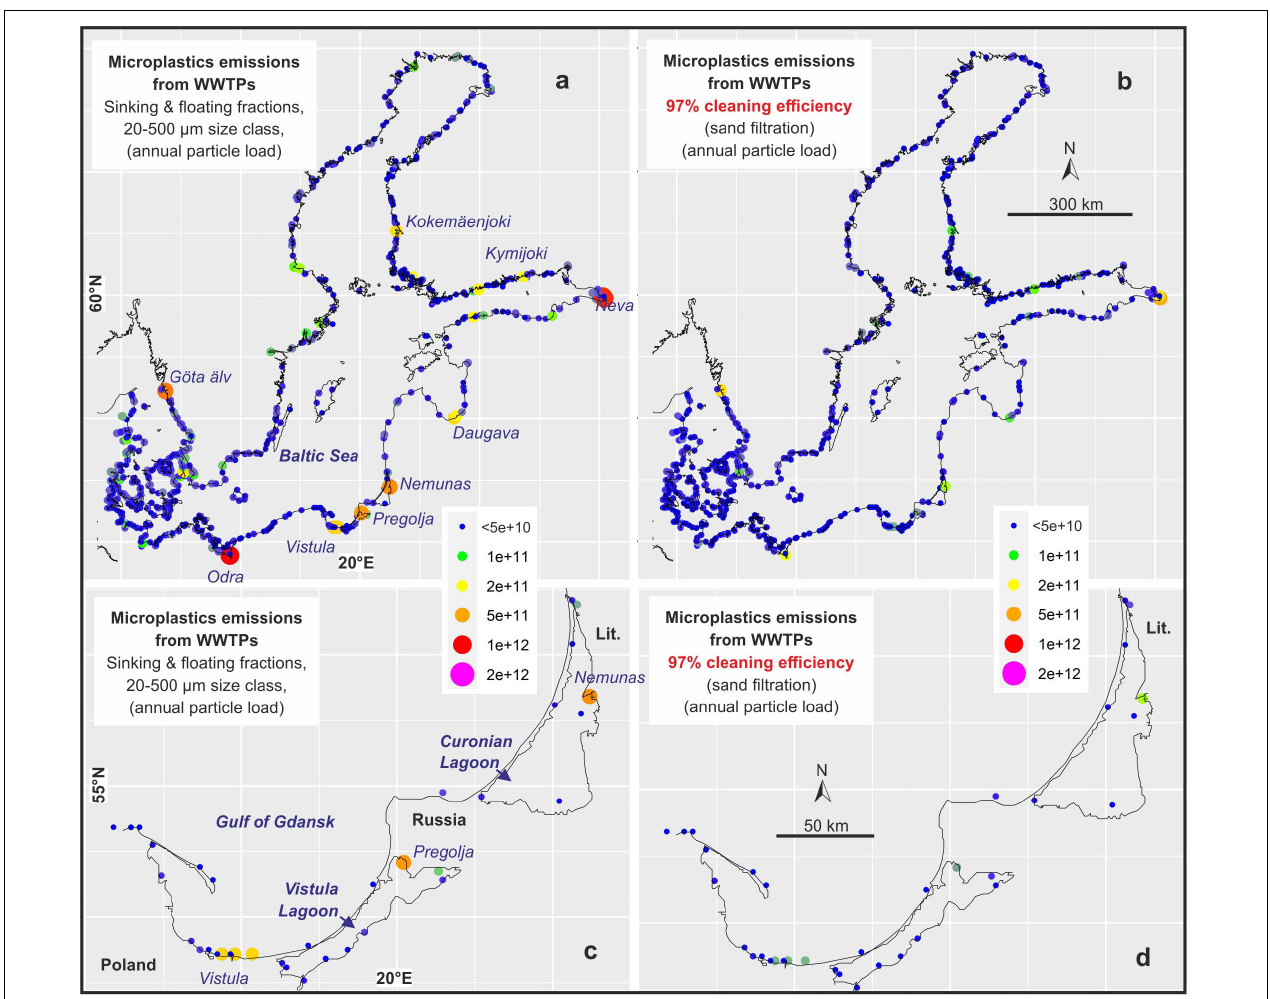
FIGURE 6 | Annual spatial emission pattern of micro-plastic particles only from wastewater treatment plants (WWTPs) to the Baltic Sea, (a) assuming no micro-plastics retention in rivers and (b) spatial emission pattern emissions into the Baltic Sea assuming that all WWTPs have a 97% cleaning efficiency. Panels (c,d) show the same data focussed on the Gulf of